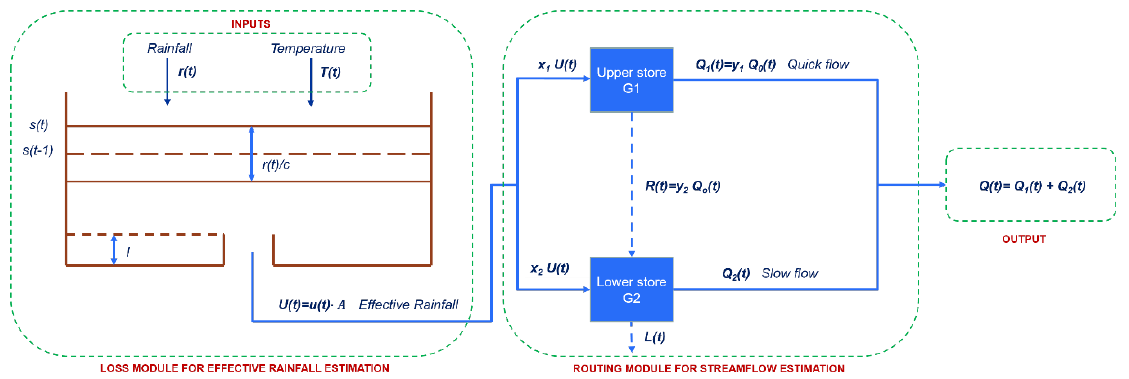
Figure 4. Structure of the modified coupled aquifer-river IHACRES model.